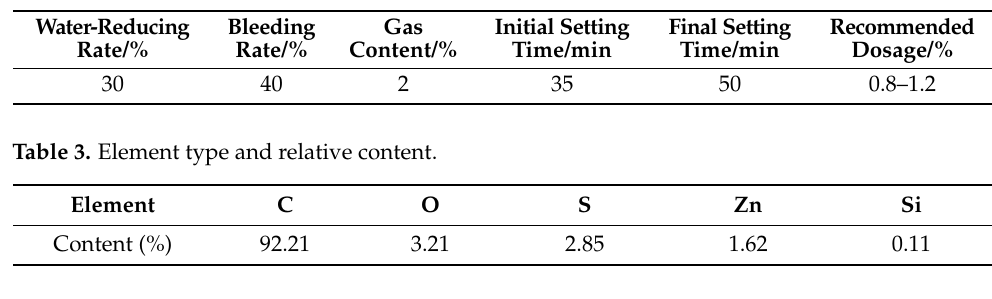
Table 3. Element type and relative content. Table 4. Technical indexes of rubber particles.